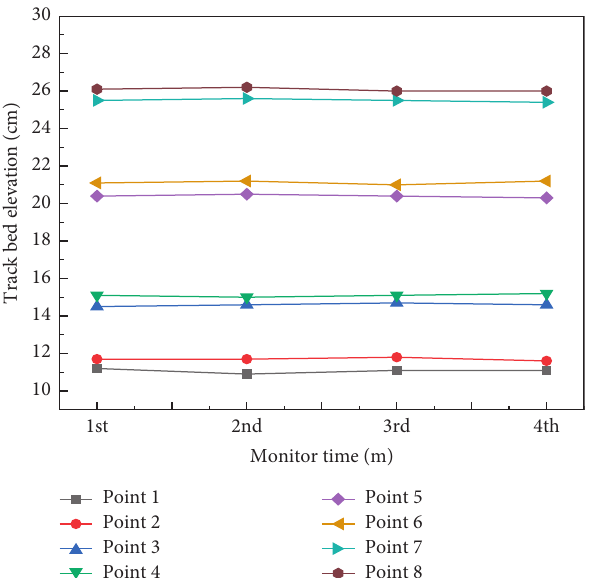
Figure 5: Time-dependent curves of track bed